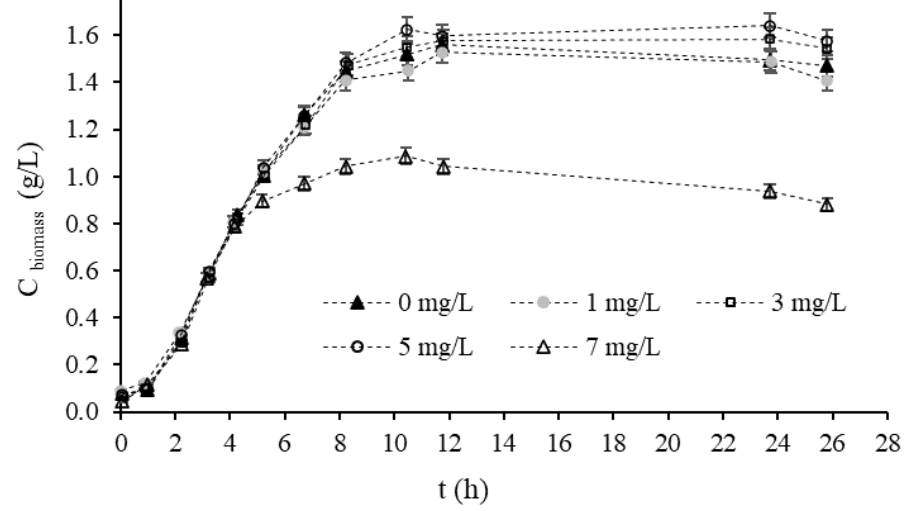
Figure 2. Toxicity assessment of atrazine. Biomass concentration along time for different initial concentrations of atrazine.